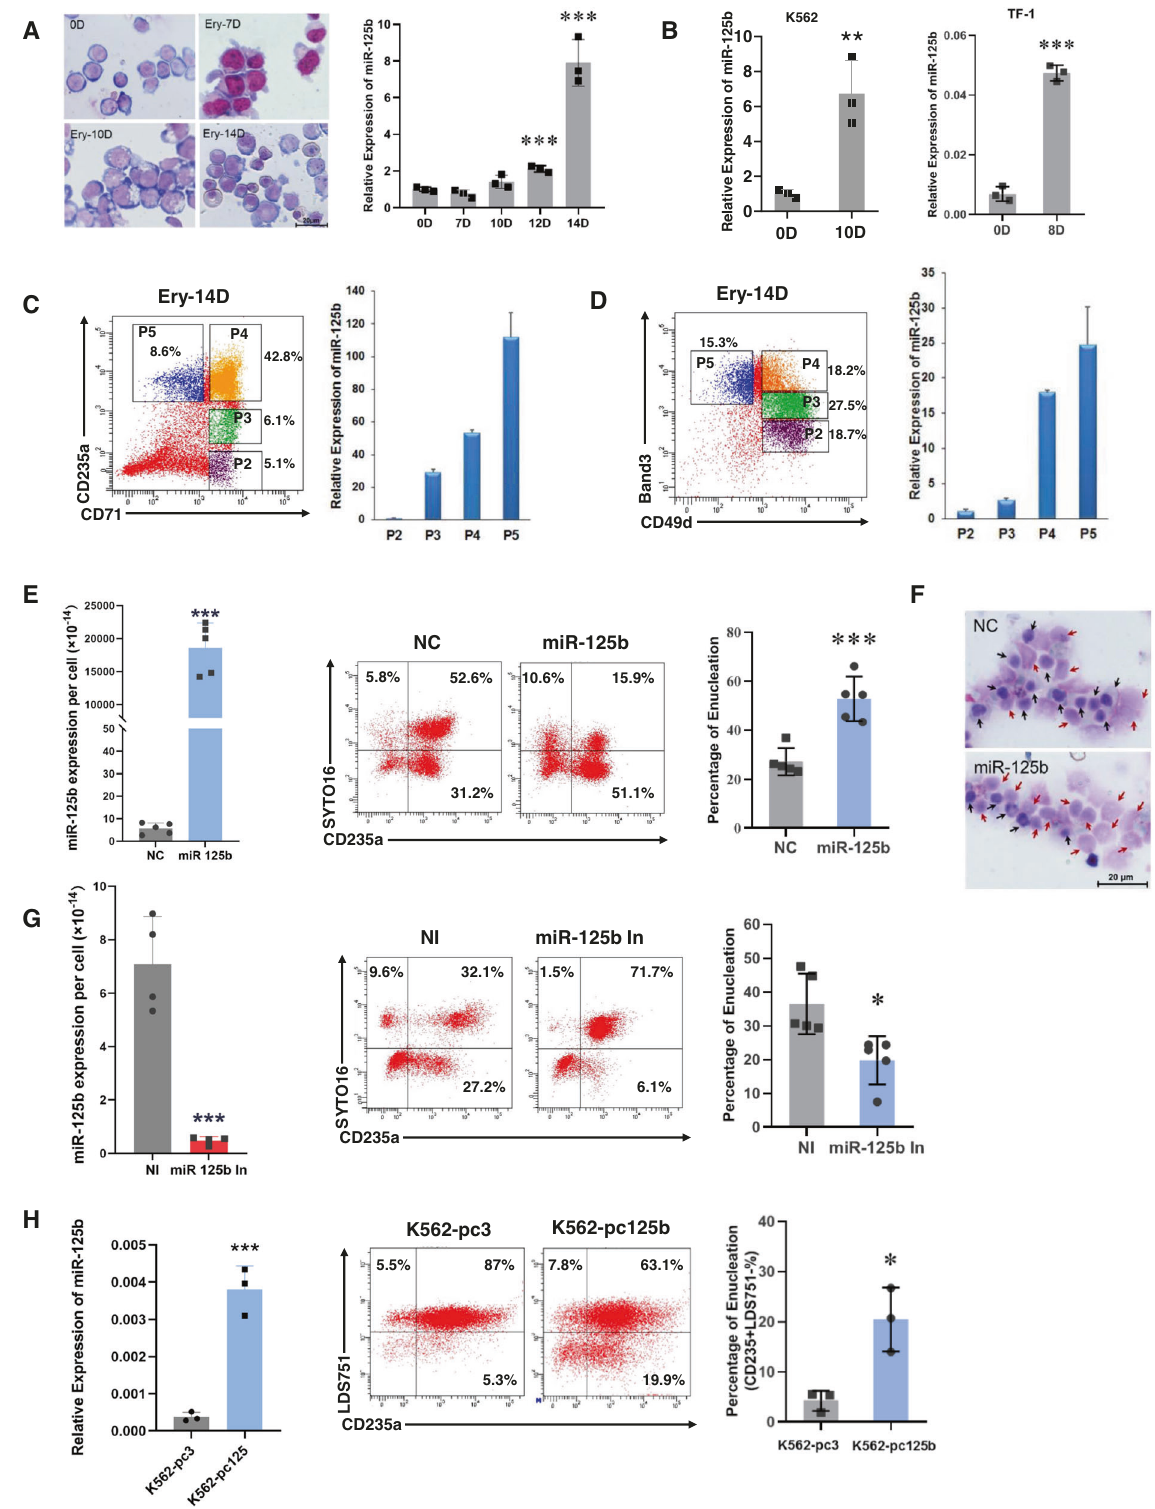
miR-125b KD increased erythroblast cell size (Fig. 5L) and nuclear size (Fig. 5M), the nuclear/cytoplasmic ration also showed a trend of enhancement although non-statistically signi fi cant (Fig. 5N and Fig. S10A). Enlarged phalloidin staining area (Fig. 5O) and reduced phalloidin fl uorescence intensity (Fig. 5P and Fig. S10B) from